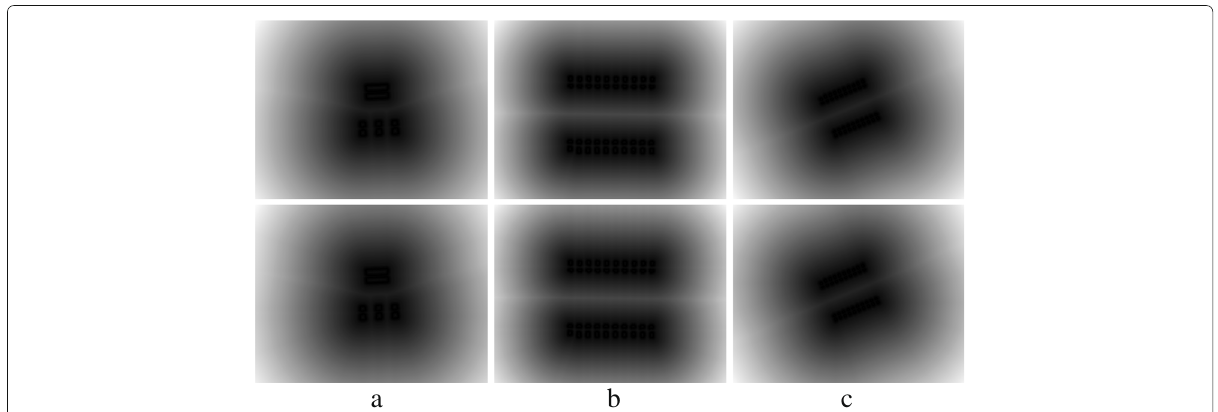
a b c Fig. 13 Distance maps generated by the 7 × 7 chamfer masks: first row, reference (Euclidean metric); and second row, proposed DT. a SOP1. b SOP2. c